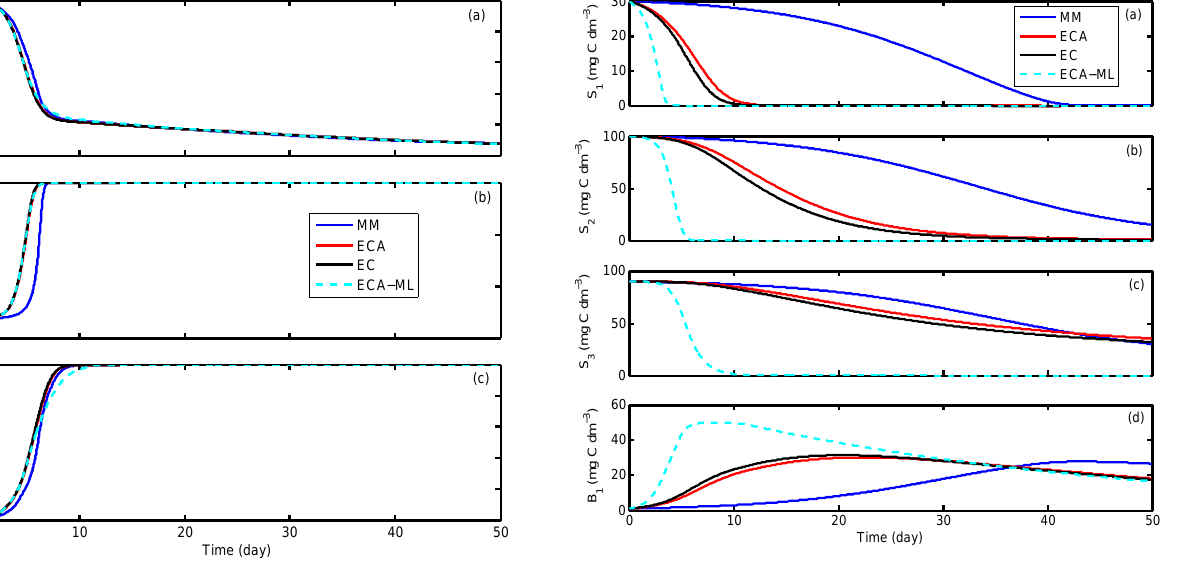
Fig. 5. Time series of state variable ratios simulated from the appli- cation of the four different substrates uptake kinetics to microbial model S3B1.